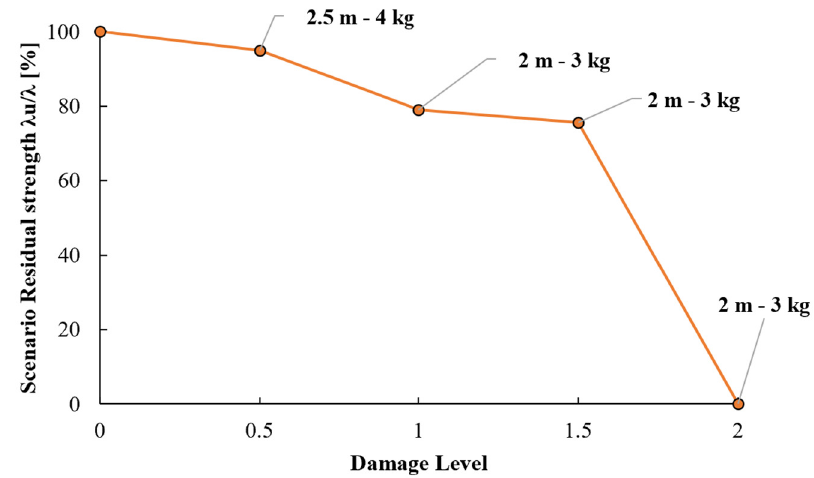
Figure 16. BSR curve for location 1.